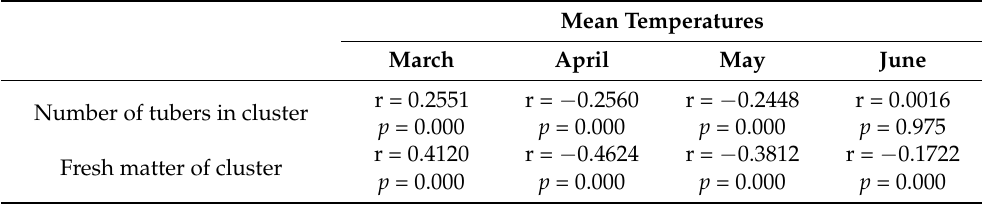
Table 4. Correlation matrix of mean temperatures and size of tuber cluster (its FM and number of